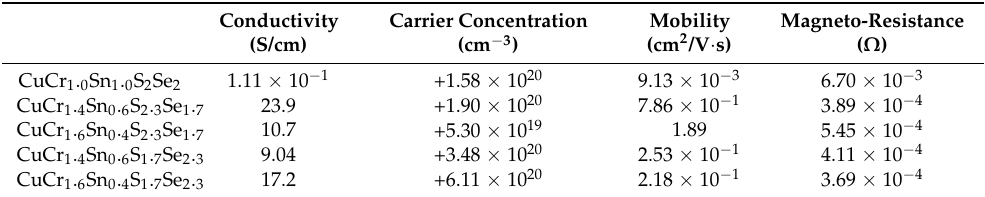
Table 3. Transport properties obtained from Hall-effect measurements of CuCr 2- x Sn x S 2 . 3 Se 1 . 7 and CuCr 2- x Sn x S 1 . 7 Se 2 . 3